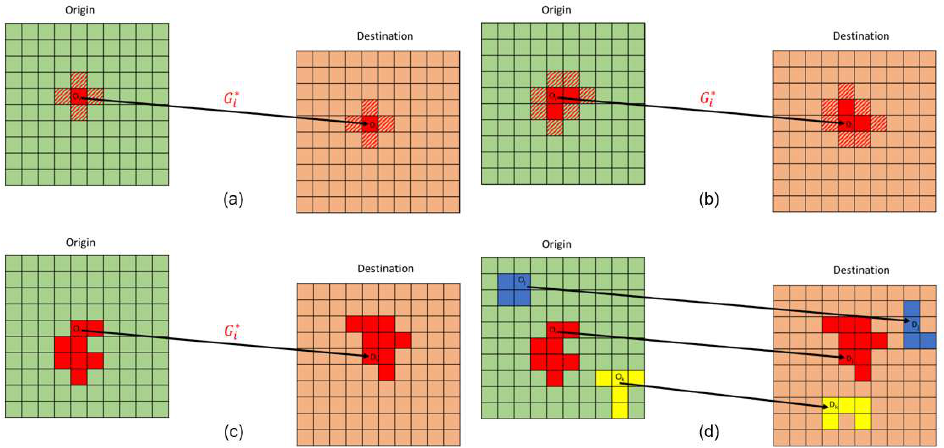
Figure 3. Different stages of the flow cluster expansion: ( a ) starting from a seed flow ( b ) flow cluster enlarged but still expanding ( c ) stable stage of one flow cluster. ( d ) stable stage of multiple flow clusters regarding different seed locations.